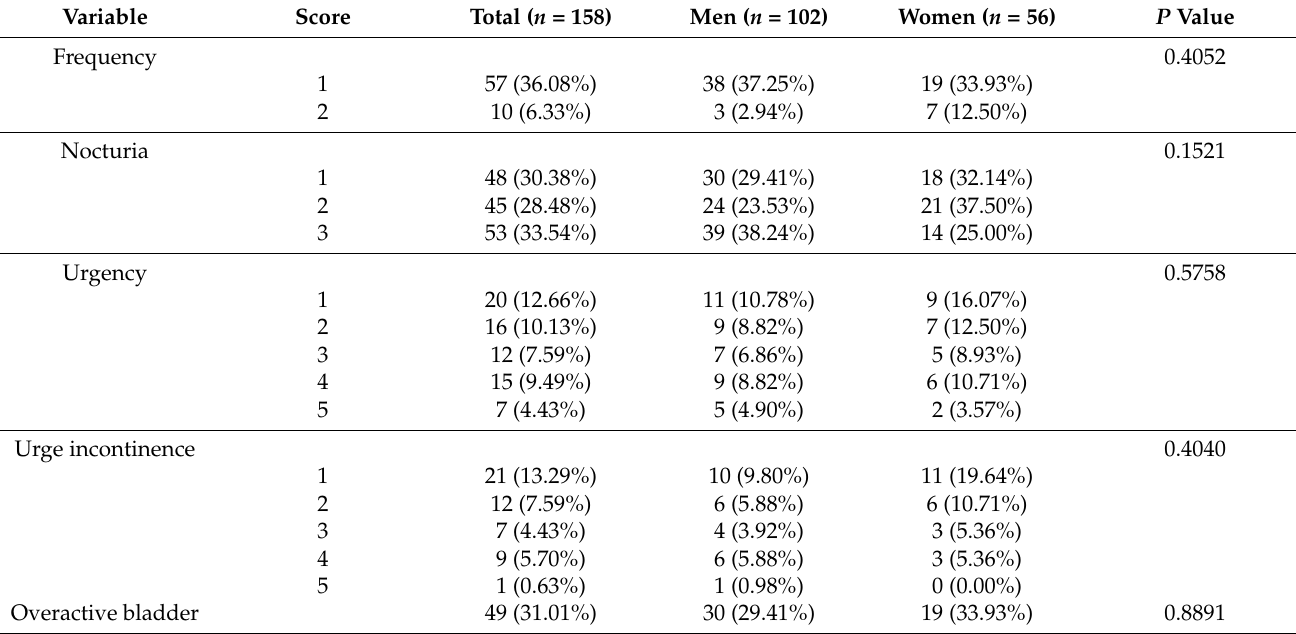
Table 2. Results of the OABSS questionnaire between genders.